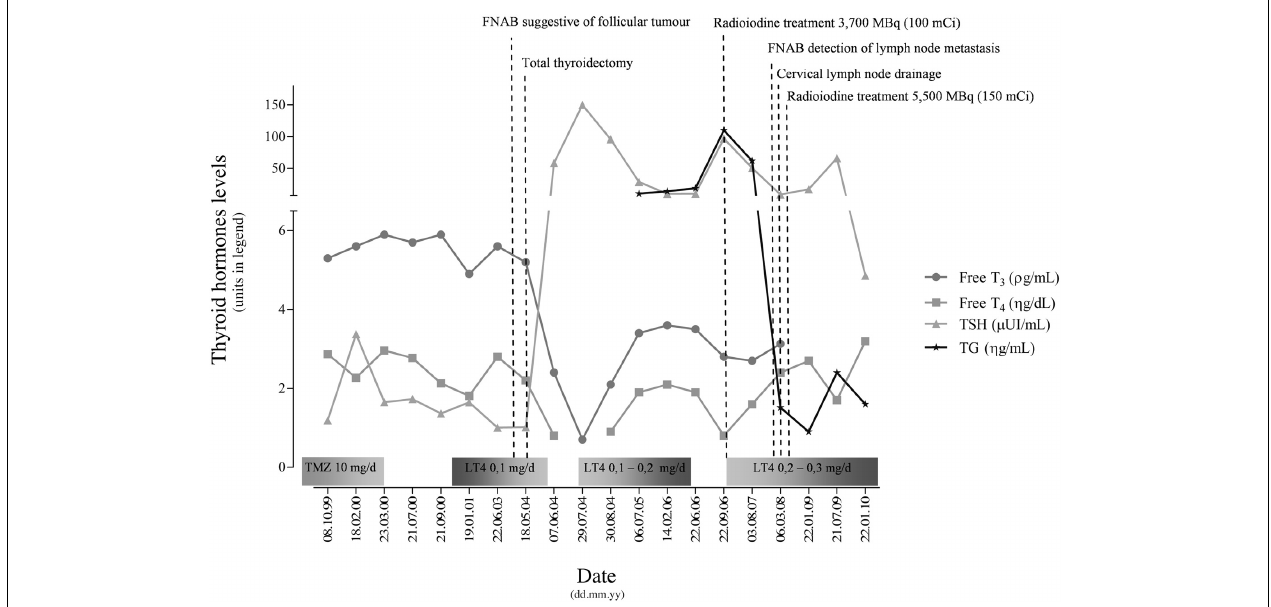
FIGURE 1 | Major events, clinical measurements and therapy management of the patient referring the period on first appearance until the last appointment. Abbreviations: TMZ, Thiamazole; LT4, Levothyroxine.